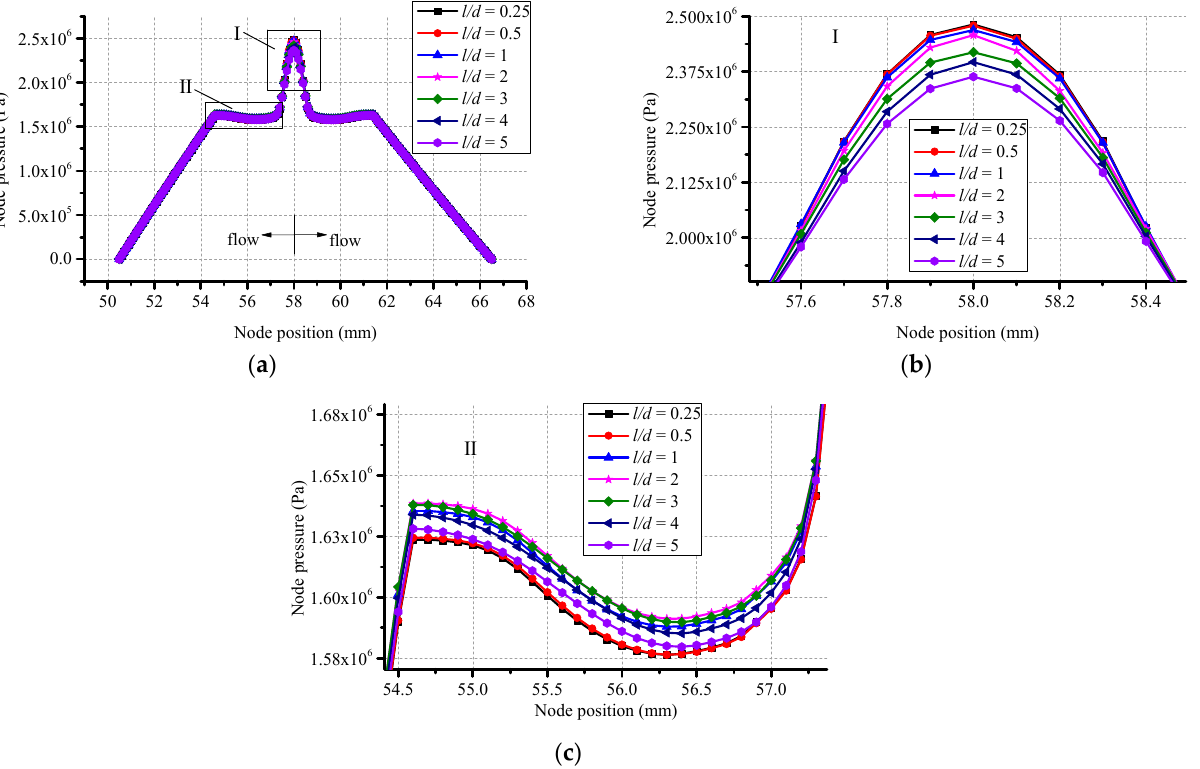
Figure 7. Pressure patterns of various OLDRs along the line of b 1 – b 2 . ( a ) Node pressures of various OLDRs along the line of b 1 – b 2 ; ( b ) local enlarged view of Ⅰ ; ( c ) local enlarged view of Ⅱ .